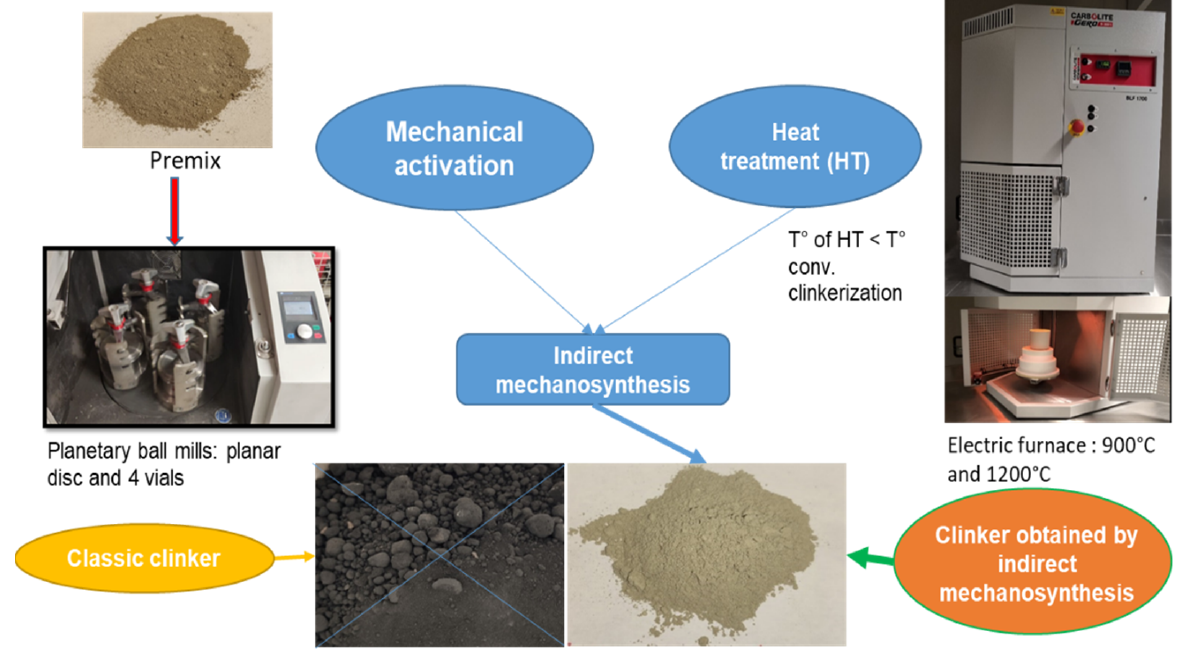
Figure 1. Illustration of the clinkerization process by indirect mechanosynthesis. Table 2. Chemical composition of the mixes used for the clinkerization process.